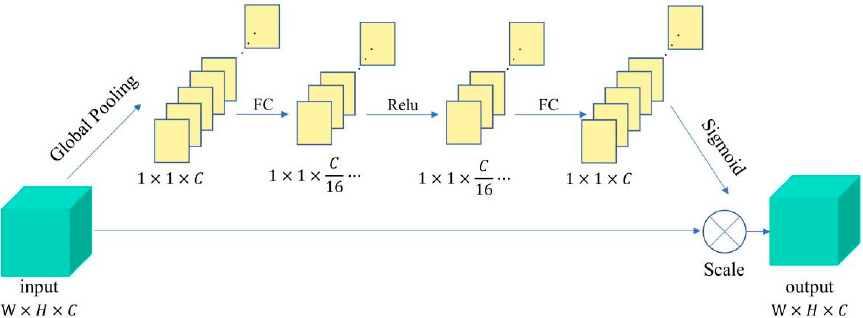
Figure 7. SE block Figure 7. SE block structure.